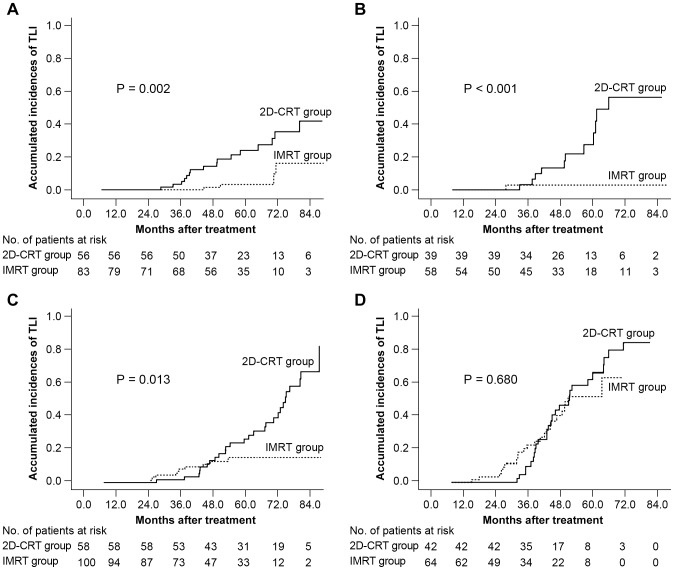
Kaplan-Meier curves comparing the probability of temporal lobe necrosis in T1-T4 patients.T1 disease (A), T2 disease (B), T3 disease (C), T4 disease (D) treated with intensity-modulated radiotherapy (IMRT) or two-dimensional conventional radiotherapy (2D-CRT).